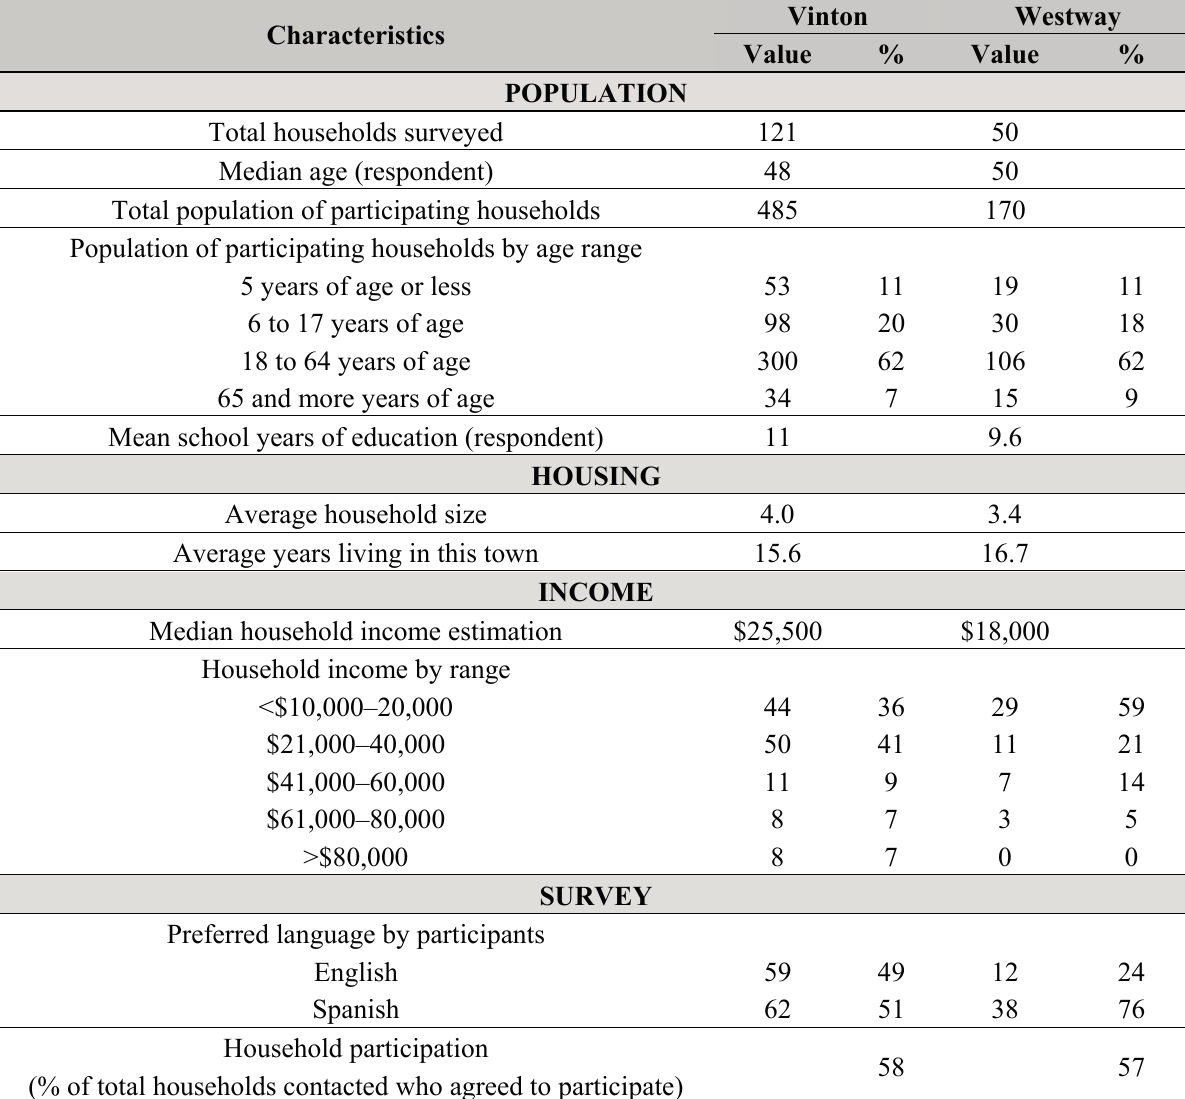
Table 2. Demographics of participants in our surveys in Vinton and